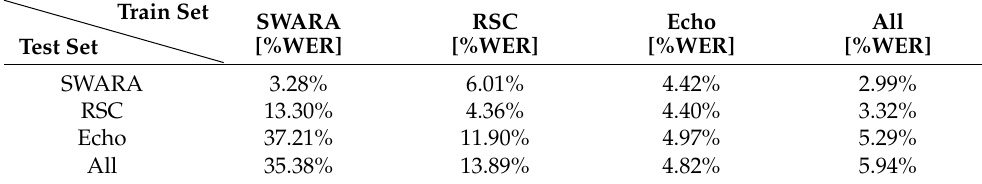
Table 8. Word error rates when training and testing various Romanian models. All four models were trained using only the “train” subset, whereas the evaluation was performed exclusively on the “test”